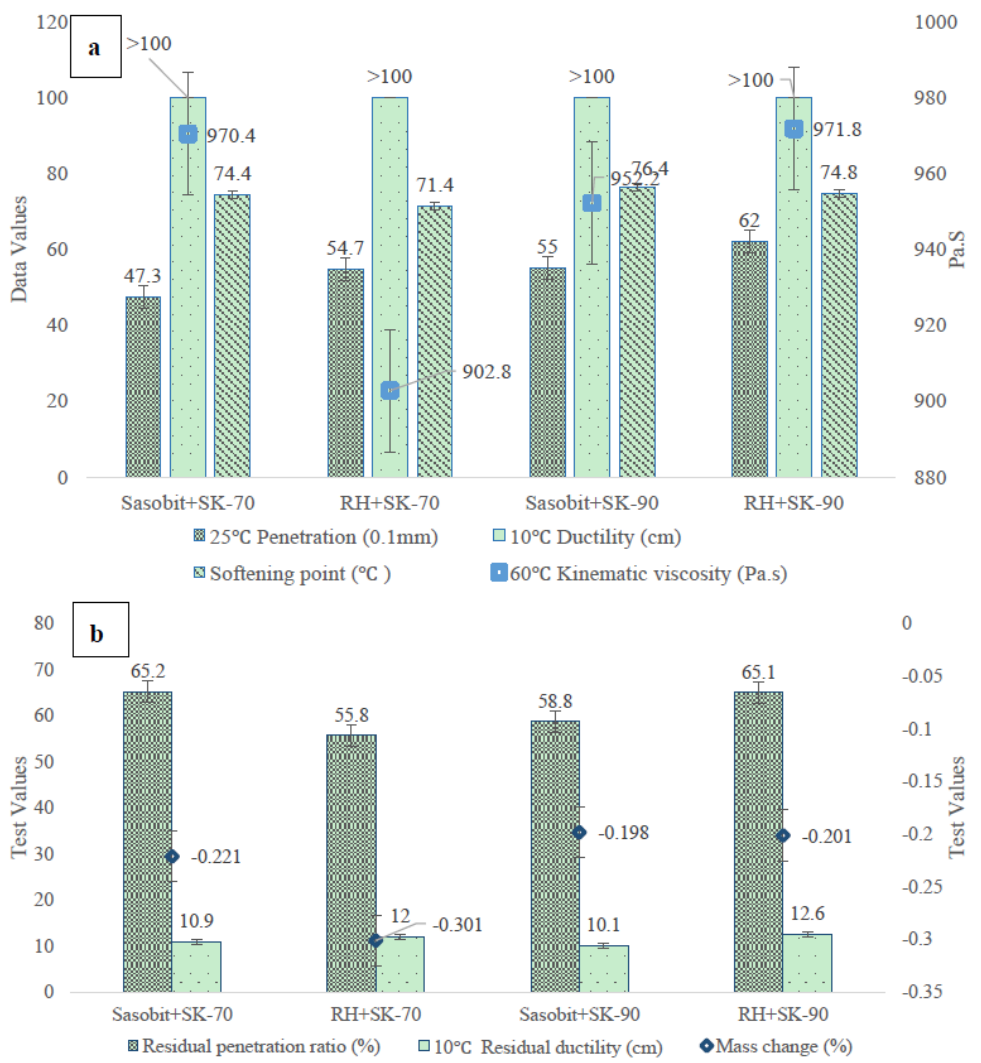
Figure 3. Properties of Organic Additive-Modified Asphalts, ( a ) Penetration, Ductility, Softening Point, Kinematic Viscosity of asphalt binders; ( b ) Residual Penetration Ratio, Residual ductility, and Mass Change of asphalt binders.